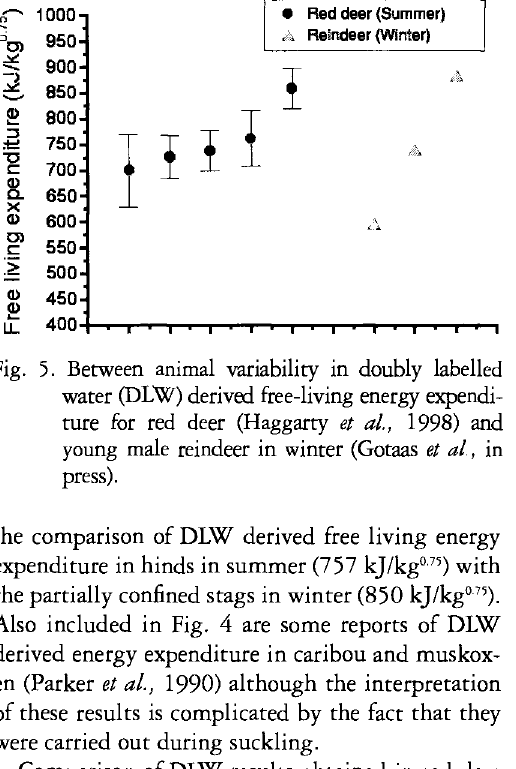
Fig. 5. Between animal variability in doubly labelled water (DLW) derived free-living energy expendi ture for red deer (Haggarty et al., 1998) and young male reindeer in winter (Gotaas et al, in press).